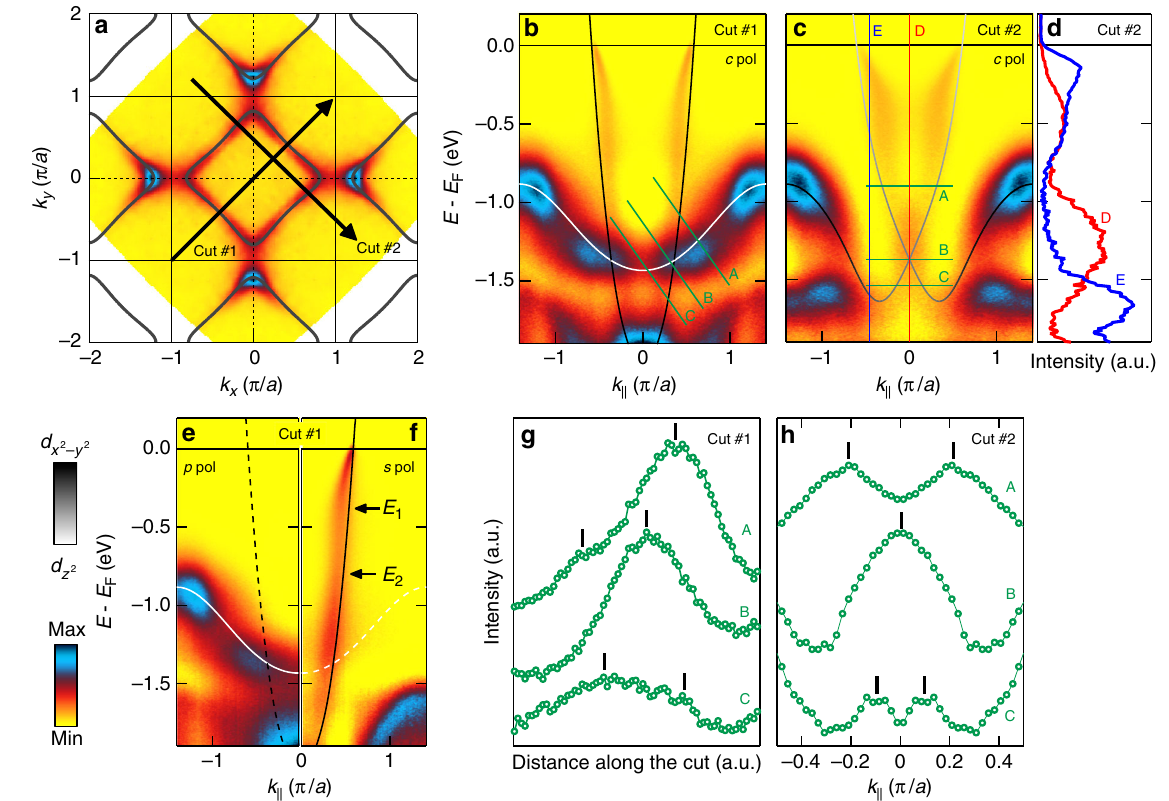
Fig. 2 Nodal type-II Dirac cone in La 1.77 Sr 0.23 CuO 4 . a Symmetrised Fermi surface map recorded using circularly polarised 160 eV photons. Solid black curves are a tight binding parametrisation of the electron-like Fermi surface. The arrows indicate nodal and orthogonal to nodal cuts. b Nodal band dispersion [cut #1 in a ] recorded with circular polarisation symmetrised around Γ and compared to a two-band ( d x 2 (cid:1) y 2 and d z 2 ) tight-binding model. The crossing of the two bands de fi nes the type-II Dirac cone. c Spectra going through the Dirac point in the orthogonal-to-nodal direction [cut #2 in a ] and symmetrised around the nodal line. As indicated by the tight-binding model, the repulsive interaction leads to orbital hybridisation. d Energy distribution curves along the cuts D and E in c . e , f Same spectra as in b , but acquired with linear p and s polarisation, respectively. Solid and dashed lines indicates the tight-binding model. The on/off switching demonstrates the even and odd mirror symmetries of the two bands constituting the Dirac cone. These symmetry protected properties are not in fl uenced by correlation induced self-energy effects. The waterfall feature indicated by the energy scales E 1 and E 2 is discussed brie fl y in the text. Background subtraction has been applied to panels b , c , e , and f (see Supplementary Figs. 1, 2, and Supplementary Note 1). g , h Intensity distributions along the cuts A – C indicated in b and c , respectively. Black bars mark the peak positions